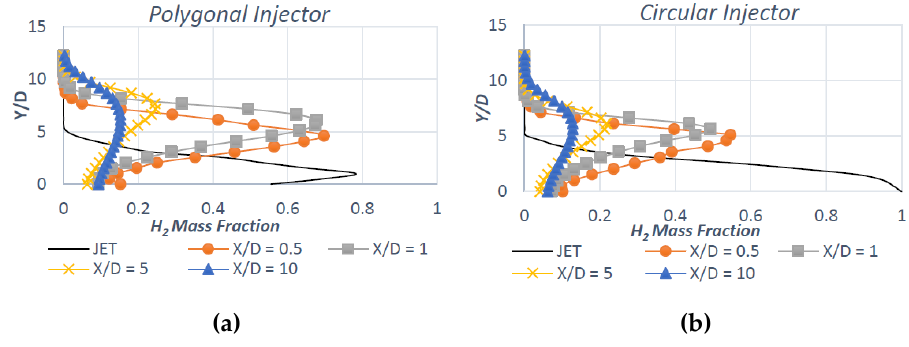
Figure 15. ( a ) Polygonal jet penetration height; ( b ) Elliptical jet penetration height.